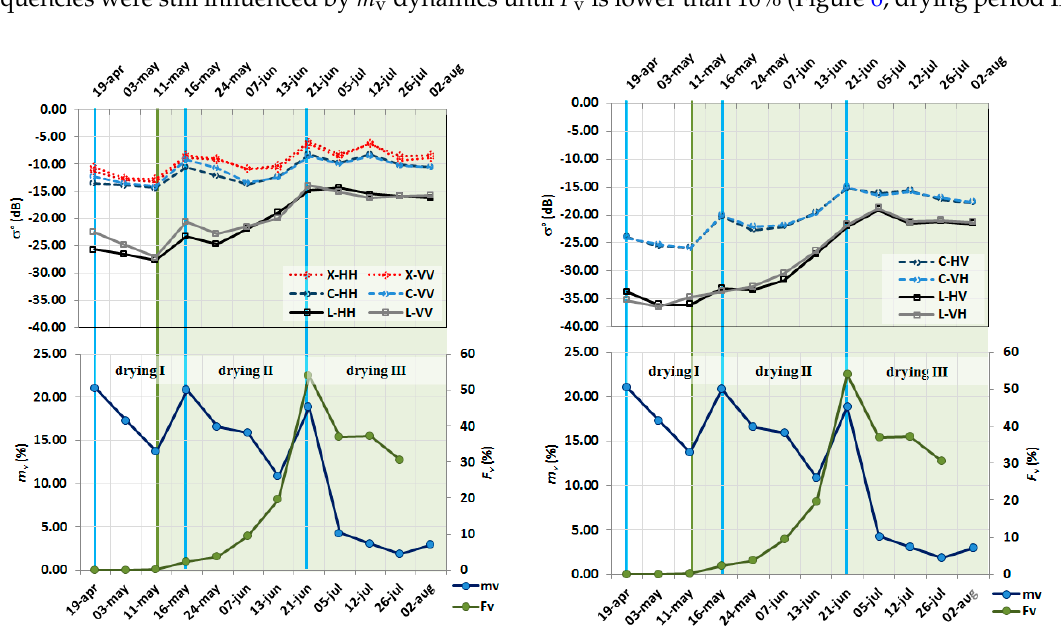
Figure 6. SVV ( m v and F v ) and σ ° temporal dynamics for the plot 460 (sugar beet); co-polarized σ ° are shown in the upper left panel, whereas cross-polarized σ ° are in the upper right panel. Vertical blue bars mark m v peaks separating three consecutive drying periods; the green vertical bar marks the time in which the increase of F v began.